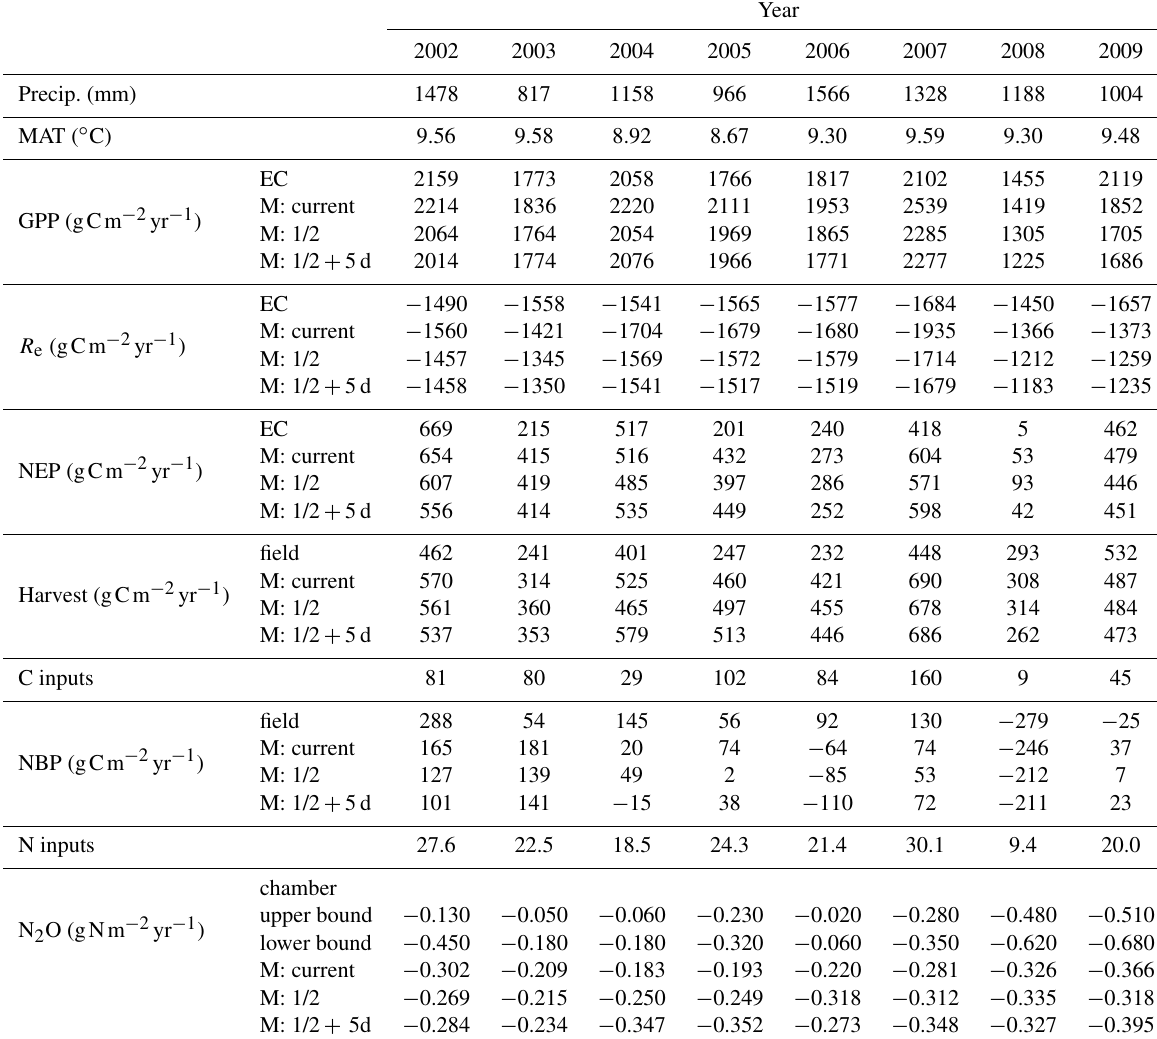
Table 4. Annual gross primary productivity (GPP), ecosystem respiration ( R e ), net ecosystem productivity (NEP = GPP − R e ), harvest, net biome productivity (NBP) and N 2 O emissions derived from EC or chambers and modelled (M) with current land management (Table 2) and with defoliation increased so that LAI remaining after harvesting was reduced by half (1/2), with defoliation increased and delayed by 5 days (1/2 + 5d). Positive values indicate uptake, negative values